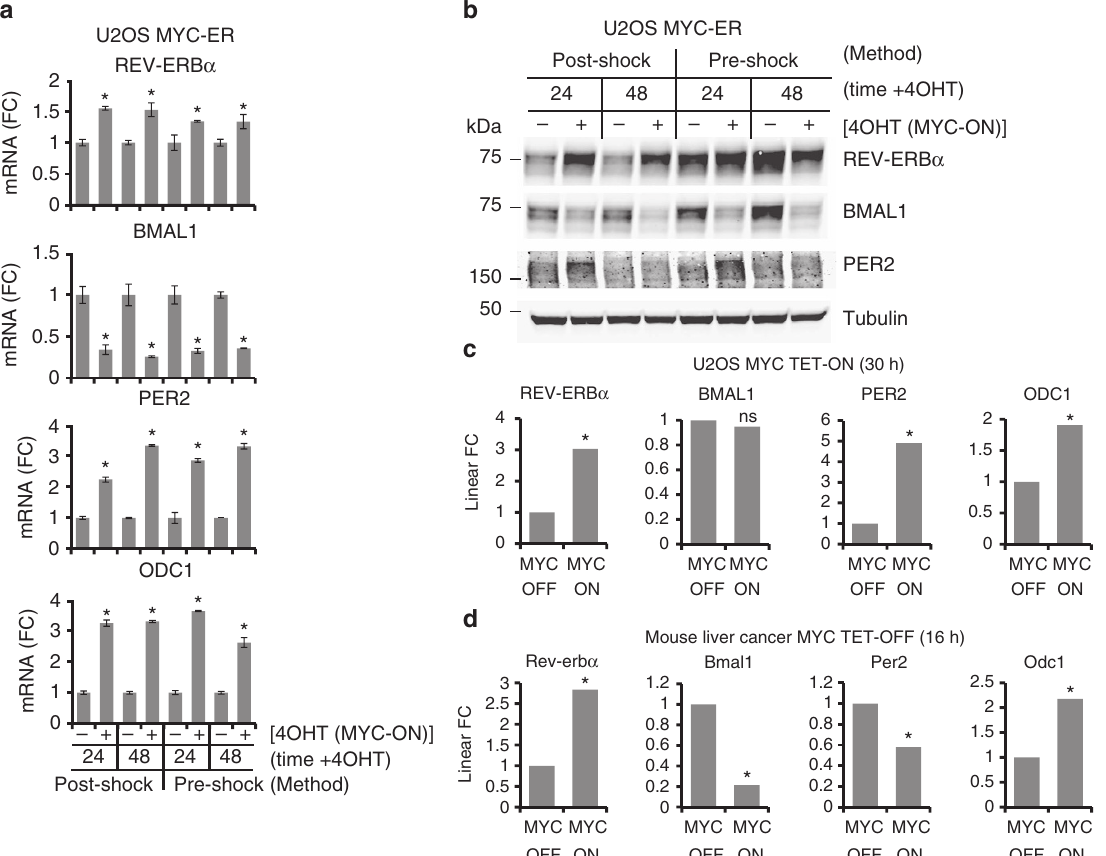
Figure 2 | REV-ERB a mRNA is induced by MYC regardless of synchronization method and in multiple cell line and tumor models. ( a , b ) MYC was induced in U2OS MYC-ER cells that were synchronized with dexamethasone in two different schemes. ‘Post-Shock’ 1 : as in Fig. 1, cells were treated ± 4 OHT (with ethanol serving as a loading control for all experiments) for 24h. The ‘24’h sample was collected, then 0.1 m M dexamethasone was added to media and the ‘48’h sample was collected 24h later. ‘Pre-Shock’ 2 : 1 m M dexamethasone was added for 20min, then cells were washed once in PBS and fresh media was added ± 4OHT. Cells were collected at the indicated times after media change. ( a ) mRNA was collected at the indicated times, and endogenous REV-ERB a ( NR1D1 ), BMAL1 ( ARNTL ), PER2 , and ODC1 were determined by RT-PCR, normalized to b 2M. mRNA (FC) ¼ fold change. Data are averages of biological triplicates with error bars representing s.d., and * P o 0.05 by Student’s t -test of 4 OHT (MYC-ON) samples relative to ethanol (MYC-OFF) samples at each time point. ( b ) Samples from ( a ) were processed for protein expression of REV-ERB a , BMAL1 and PER2. Tubulin serves as a loading control. Molecular weights are noted in kDa. ( c ) Previously published RNA-Seq data 13 from U2OS cells expressing exogenous MYC under the control of a TET-ON system and treated ± 1 m gml (cid:2) 1 doxycycline for 30h. REV-ERB a ( NR1D1 ), BMAL1 ( ARNTL ), PER2 and ODC1 were determined. Data are presented as linear fold change (FC) and represent biological triplicates, and * P o 0.05 of MYC-ON samples relative to MYC-OFF samples as previously described 13 ; NS, not significant. ( d ) Previously published RNA-seq data 14 from liver tumors driven by a MYC-TET-OFF system. Mice were fed water or doxycycline for 16h to turn off MYC. Rev-erb a ( Nr1d1 ), Bmal1 ( Arntl ), Per2 and Odc1 were determined. Data are presented as linear FC and represent biological duplicates, and * P o 0.05 of MYC-ON samples relative to MYC-OFF samples as previously described 14